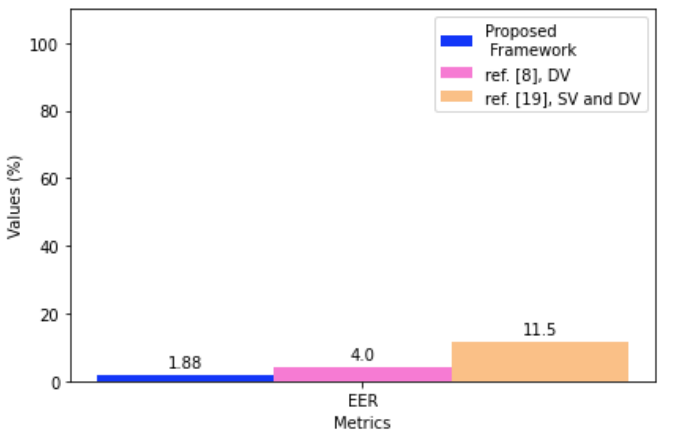
Figure 7. Performance comparison of the proposed framework with the best results from the reviewed literature for